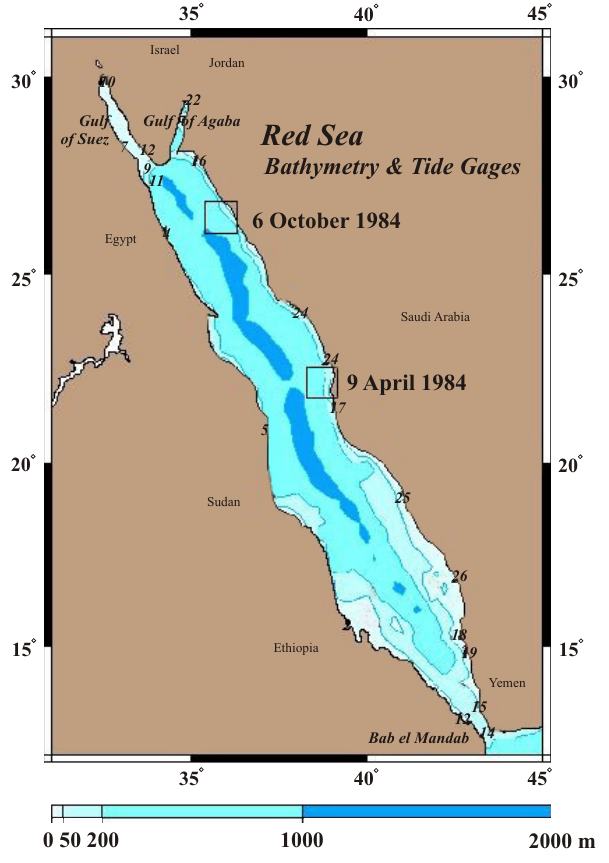
Fig. 1. The bathymetric map of the Red Sea.